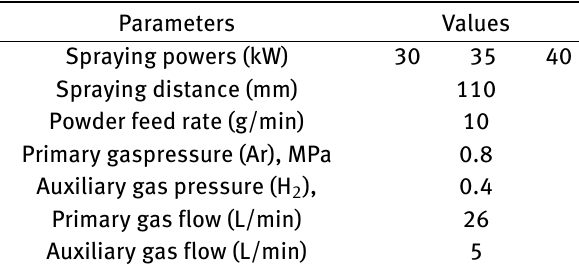
Table 2: The parameters of APS for Fe-based amorphous coatings Parameters